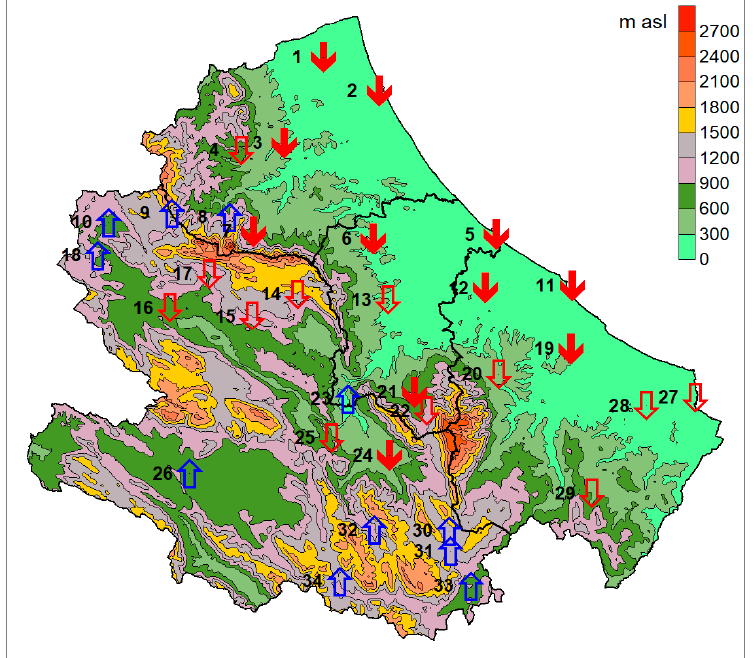
Figure 6. Trend in chilling hours accumulated from November to February. The downward arrows indicate decreasing trends, while the upward arrows denote increasing trends. Full arrows indicate significant trends with p < 0.05, while empty arrows indicate no significance. The number next to the arrow indicates the numeric code of the meteorological station. The red arrows represent a warming trend, while the blue arrows represent a cooling trend. The altitude classes are given on the upper right. The spring–summer heating caused a significant increase in GDD at all the stations— even those located in the interior areas and those in the mountainous areas (Figure 7). The station that experienced the greatest increase in GDD in the period 1980–2019 was Vasto (27), with an increase in about 400 growing degree days (Supplementary Figure S10).